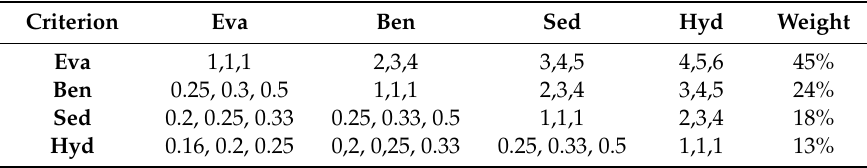
Table 3. Pairwise comparison matrix and weight using